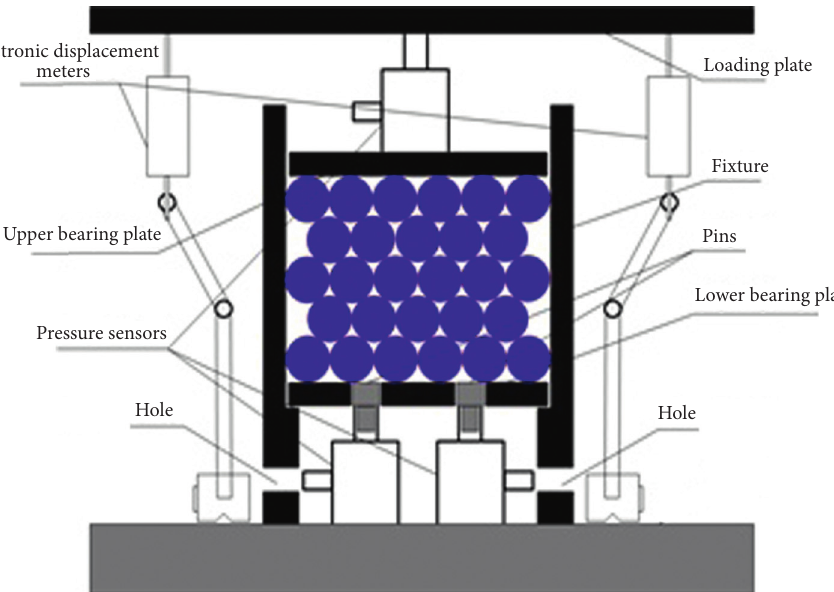
Figure 4: Sketch of particle crushing experiment.